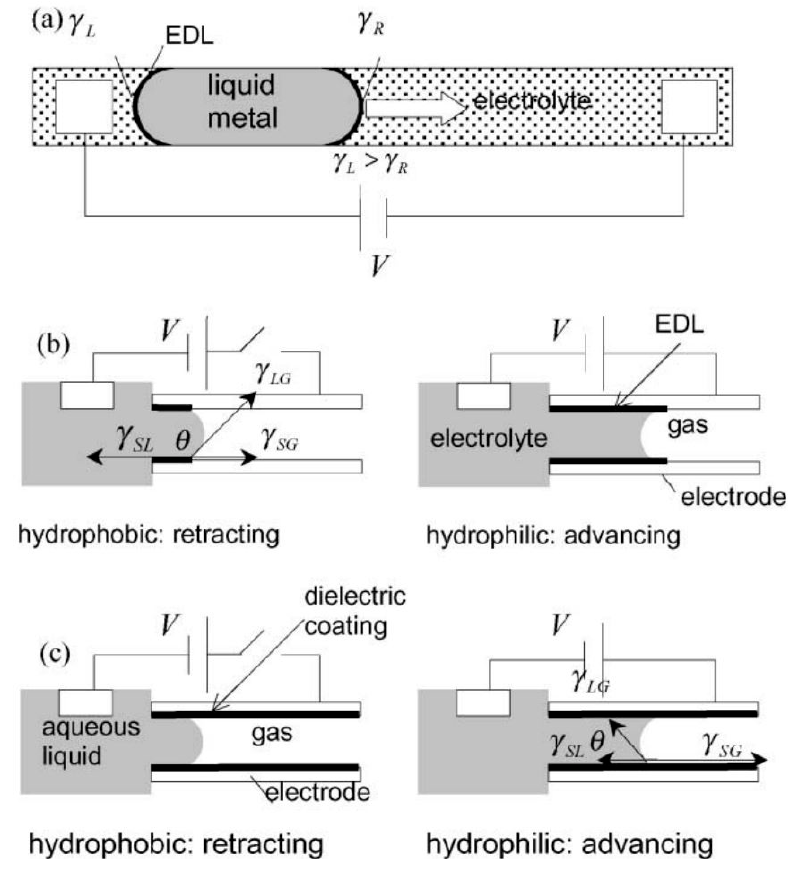
Figure 2. Schematics of electrocapillary phenomena: ( a ) continuous electrowetting (CEW); ( b ) electrowetting (EW); ( c ) electrowetting-on-dielectric (EWOD). Reproduced with permission from [27]; published by ELSEVIER, 2002.